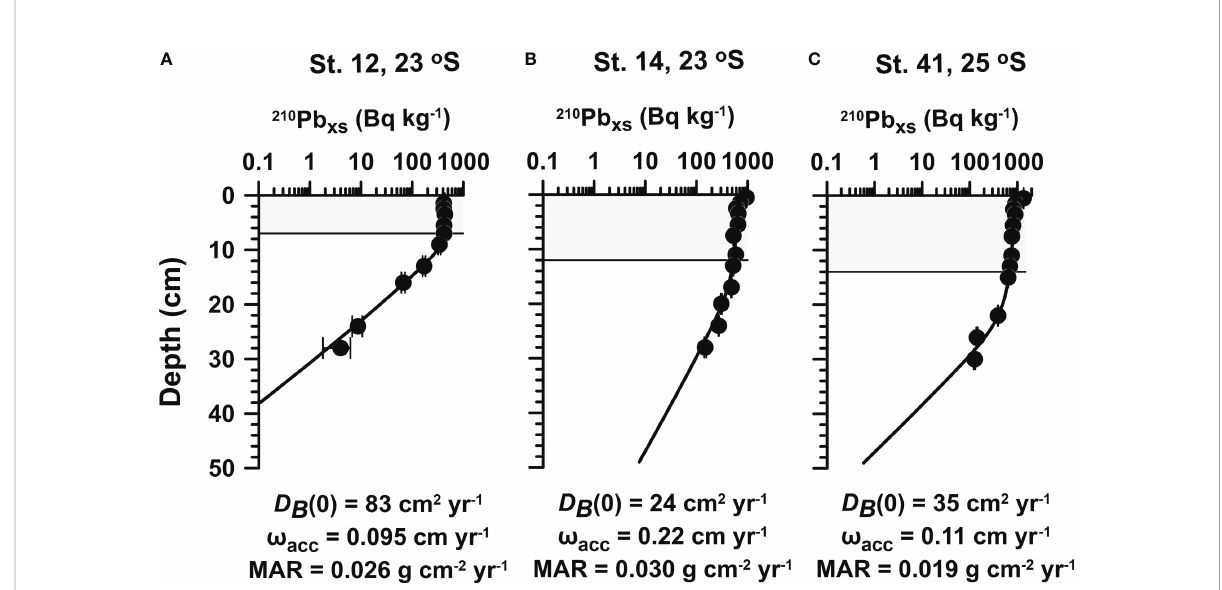
FIGURE 2 Measured (symbols) and modeled (curves) excess 210 Pb ( 210 Pb xs ) at (A) St. 12, (B) St. 14, and (C) St. 41. Mass accumulation rates (MAR), sedimentation accumulation rates ( w acc ), and bioturbation coef fi cients [ D B (0)] were calculated as described in Sampling and analytical methods . The mixed layer depth is indicated by the gray shaded